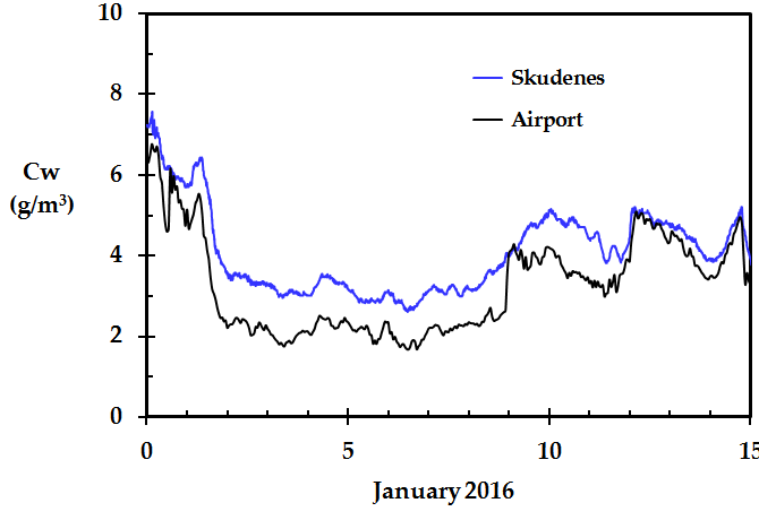
Figure 8. Calculated outdoor water concentration based on data from the meteorological station at Haugesund airport and data from the weather station in Skudeneshavn.